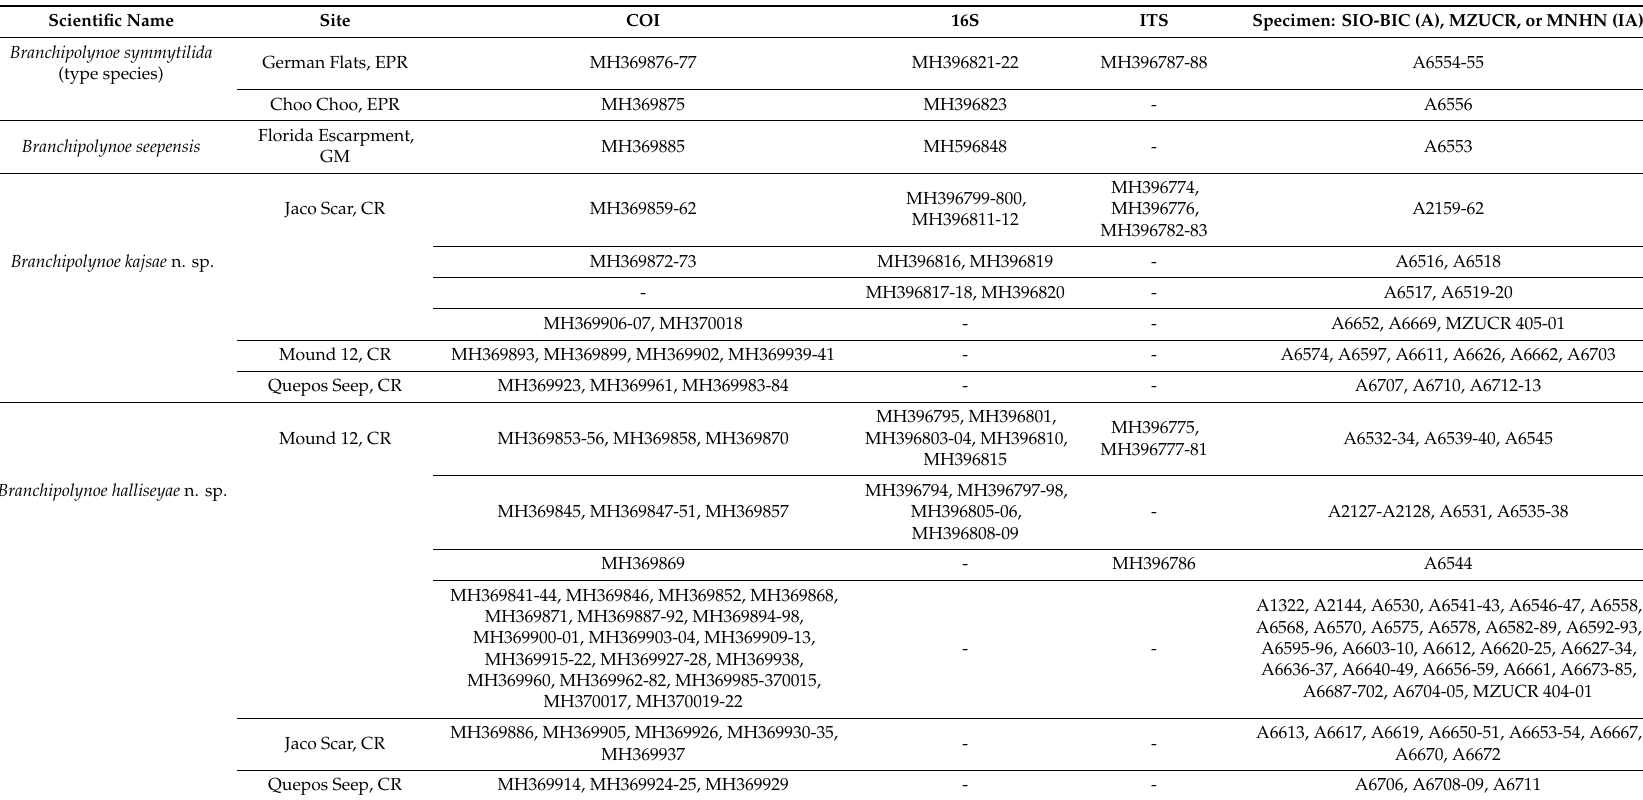
Table 1. Newly sequenced terminals, types / vouchers, and GenBank accession numbers. Sampling sites are as follows: German Flats , EPR 37.67 S, 110.88 W